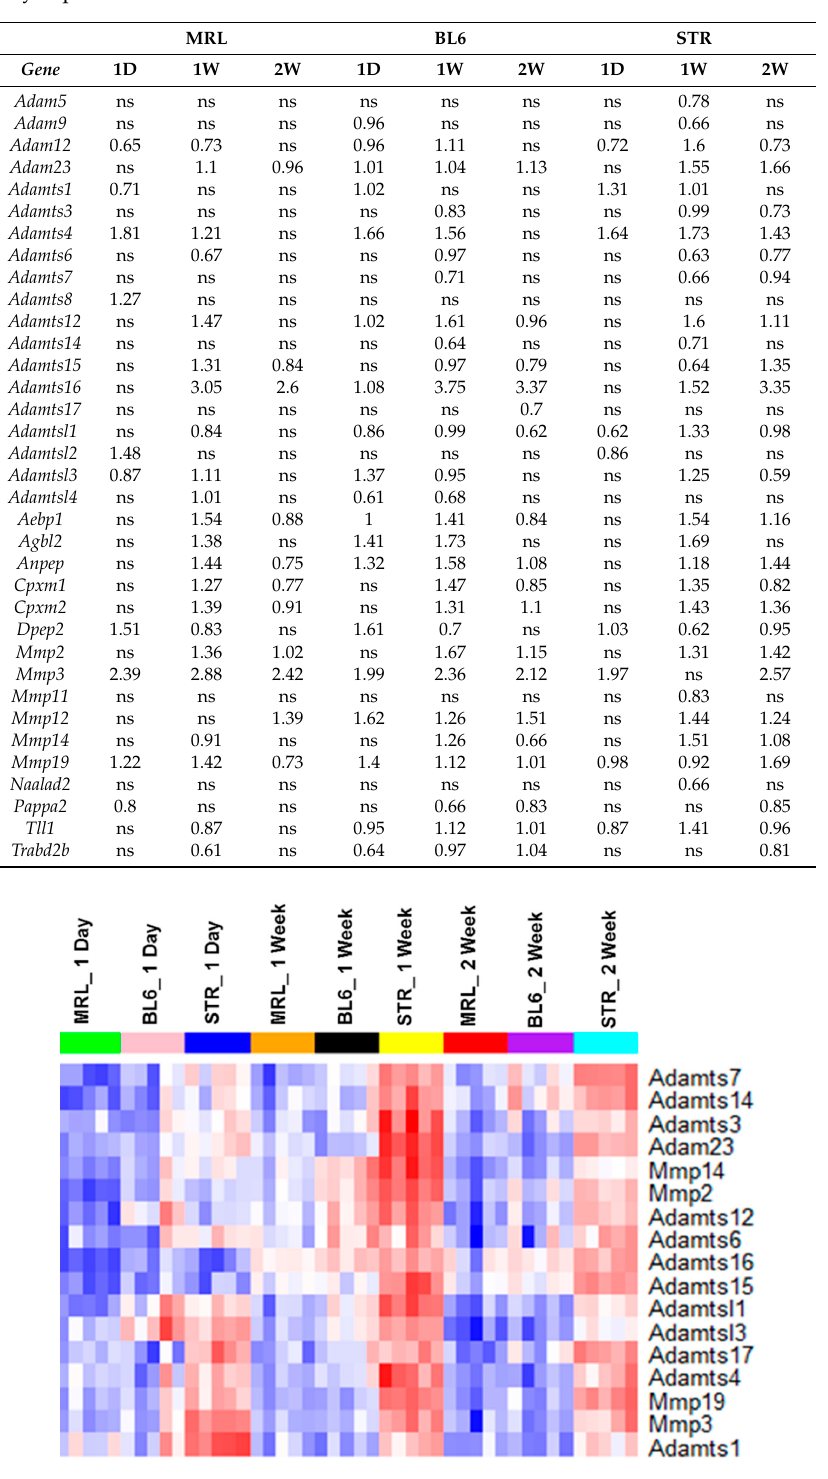
Figure 5. Matrix degrading enzymes showed highest expression in injured STR/ort. Expression of selected metalloproteinases in injured STR/ort (STR), C57BL/6J (BL6), and MRL/MpJ joints. 2.4. Potential Candidate Genes Associated with Enhanced Healing and Articular Cartilage Regeneration in MRL/MpJ